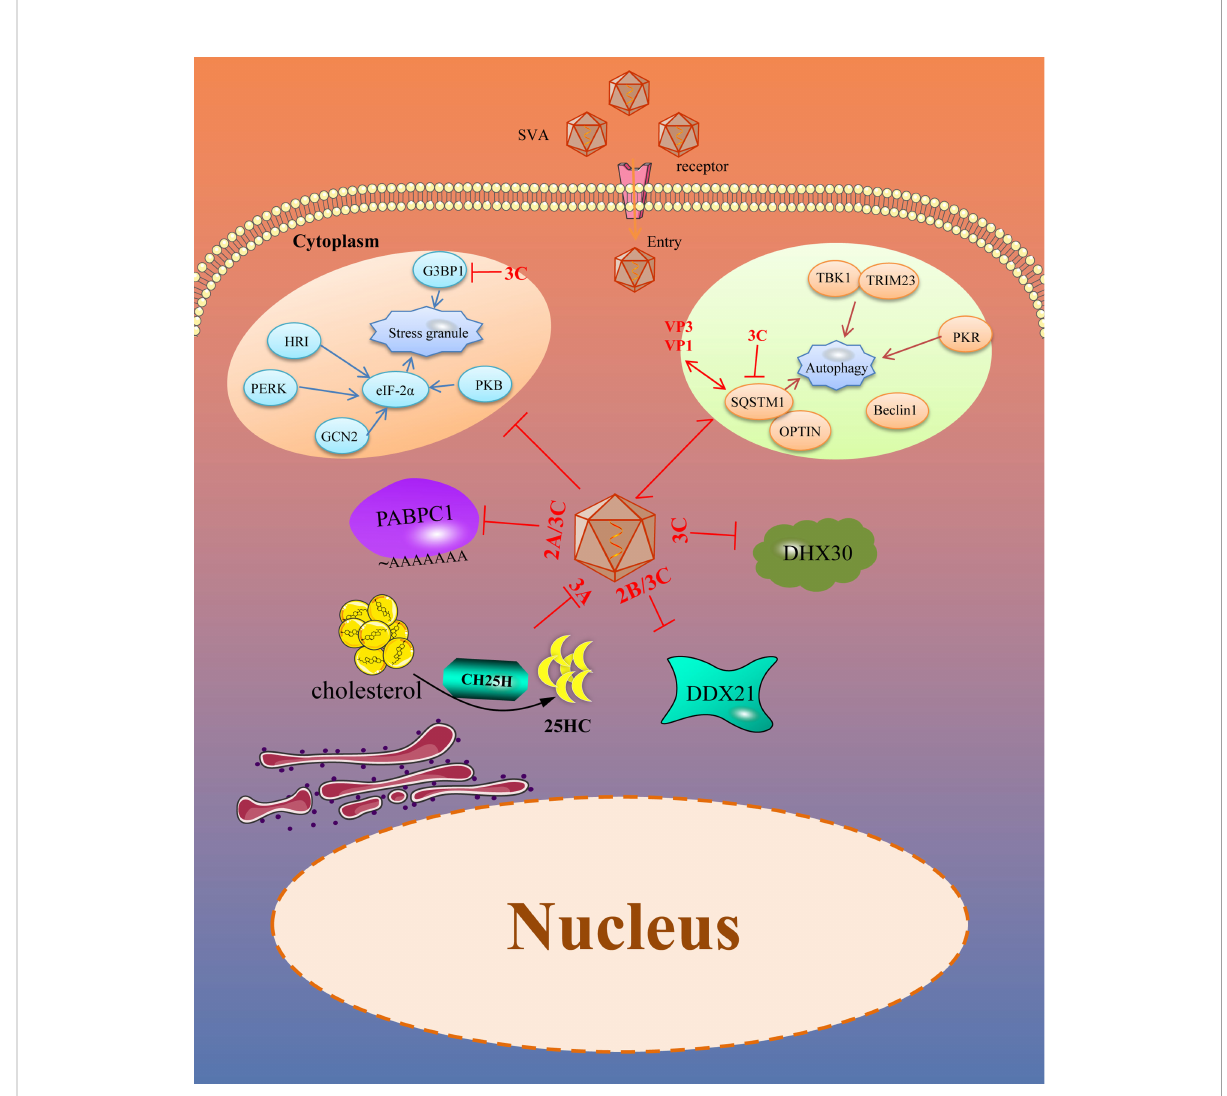
FIGURE 2 SVA evades intrinsic antiviral proteins as well as autophagy and stress granules (SGs). Viral proteins of SVA engage multiple strategies to evade the restriction of intrinsic antiviral proteins. In addition, SVA infection can trigger some other immune responses, such as SGs and autophagy, which helps to limit viral infection. However, these immune responses are also controlled by viral proteins. The solid line represents the de fi ned interaction between the adapter and the SVA protein. The red two-way arrow represents interaction, and the red T-shaped symbol represents the inhibiting